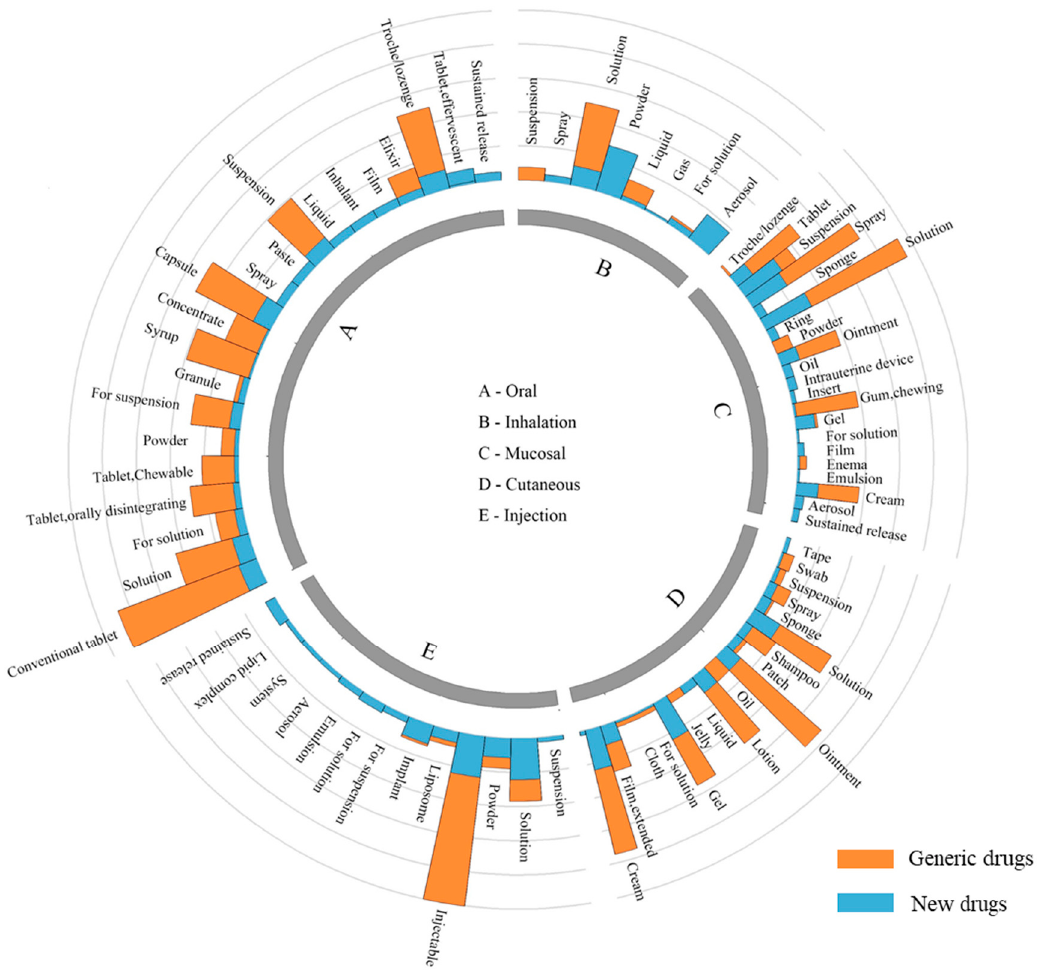
Figure 4. The distribution of dosage forms for each administration route. The orange column represents the number of generic drugs, the blue column represents the number of new drugs.